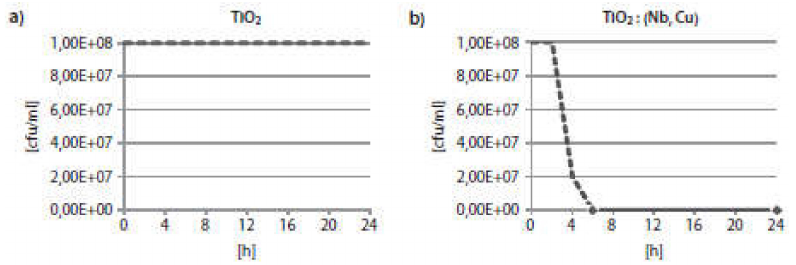
Figure 1. Biological activity over time of TiO 2 and TiO 2 :(Nb, Cu) thin films in contact with Pseudomonas aeruginosa . Reproduced with permission from Wojcieszak, D.; Domaradzki, J.; Mazur, M., Polim. Med. 2013.